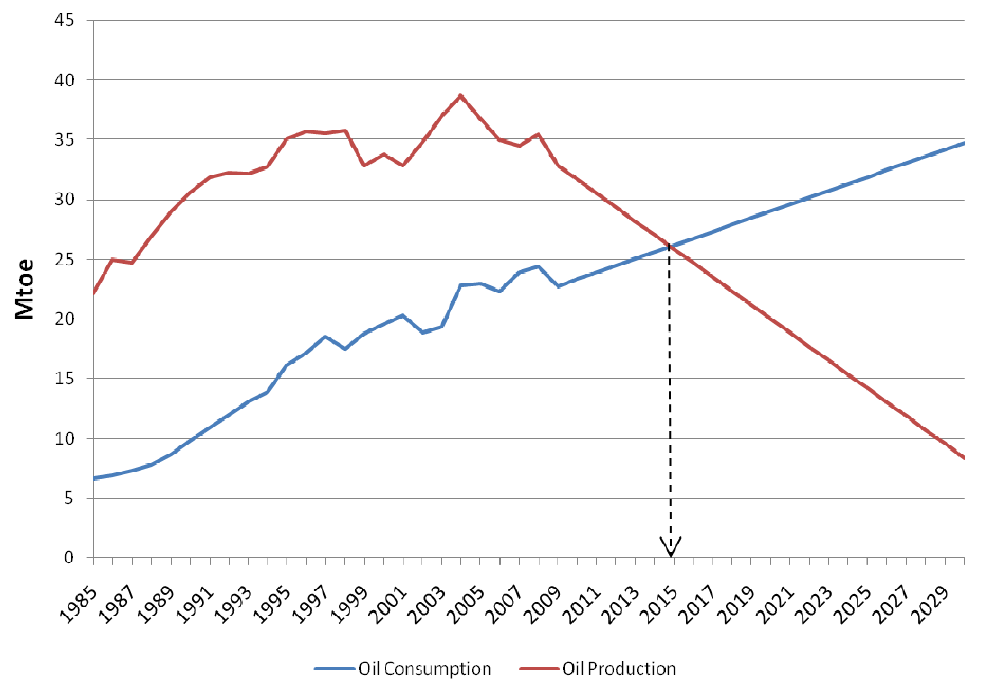
Figure 1. Calculation on Malaysia’s oil production and oil consumption based on 5 years average growth (data source: